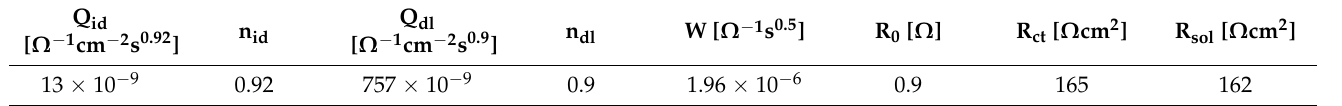
Table 2. Values for imaginary and real parameters of equivalent